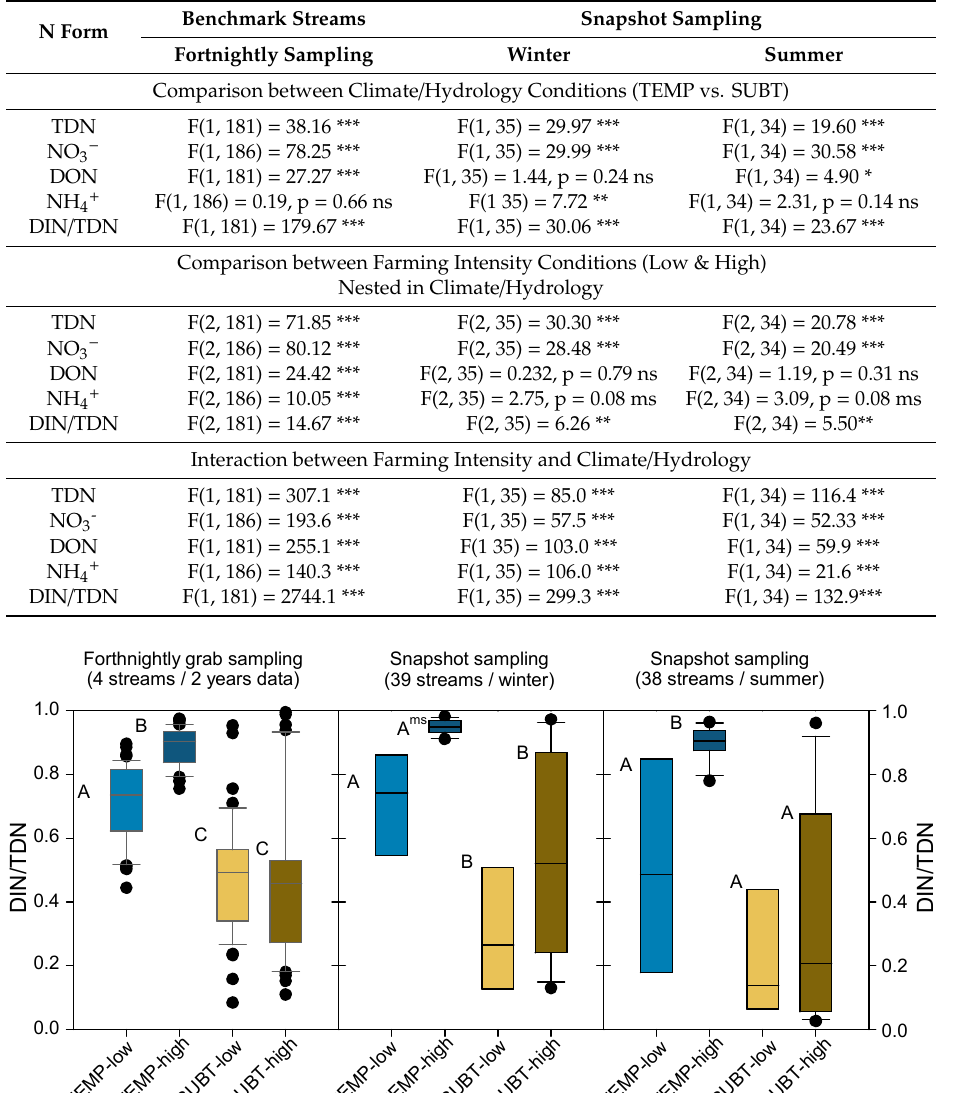
/ TDN ratio for the fortnightly grab sampling in benchmark streams and snapshot samples. Figure 5. DIN/TDN ratio for the fortnightly grab sampling in benchmark streams and snapshot Figure 5. DIN Significance level P < 0.05. A, B, and C describe statistical groups according to post hoc Bonferroni tests. We indicate marginally significant as ms (0.05 < P < 0.1). The upper and lower boundaries of the box mark the 25th and 75th percentile, whiskers above and below the box indicate the 90th and 10th percentiles and the line within the box marks the median. Black dots display outliers. Note that the scale varies among fractions. Abbreviations: TEMP: temperate streams; SUBT: subtropical streams; low and high: low and high-farming